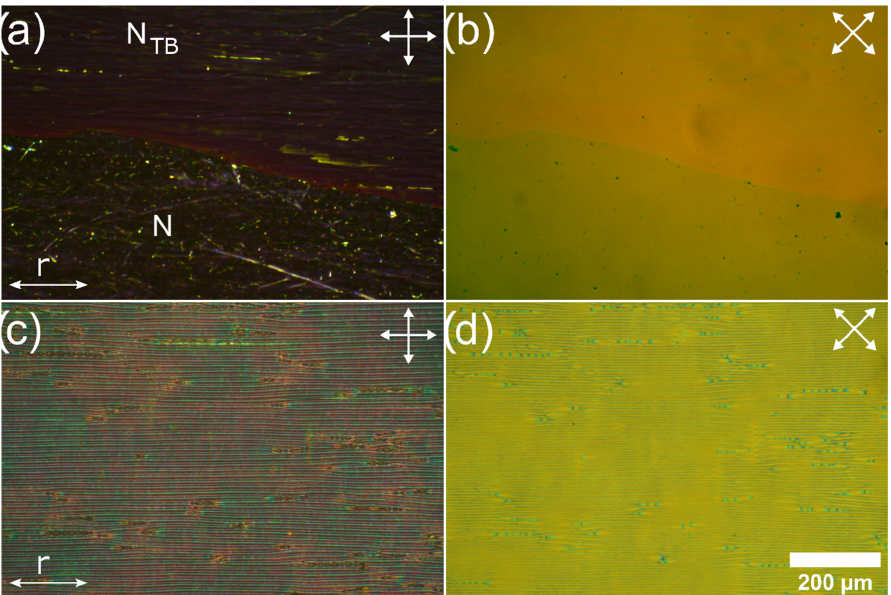
Figure 3. Polarized optical micrographs of a CB7CB/8CB mixture (50 wt%/50 wt%) observed ( a – b ) at 32 °C, during the N/N TB phase transition and ( c – d ) at 31°C in the N TB phase. Crossed polarizers; r indicates the rubbing direction.